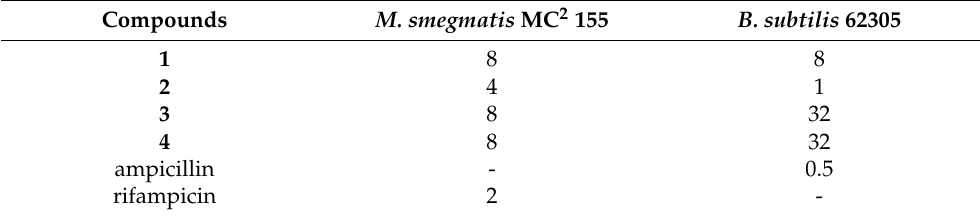
Table 1. The antimicrobial activities of 1 – 4 (MIC, µ g/mL).